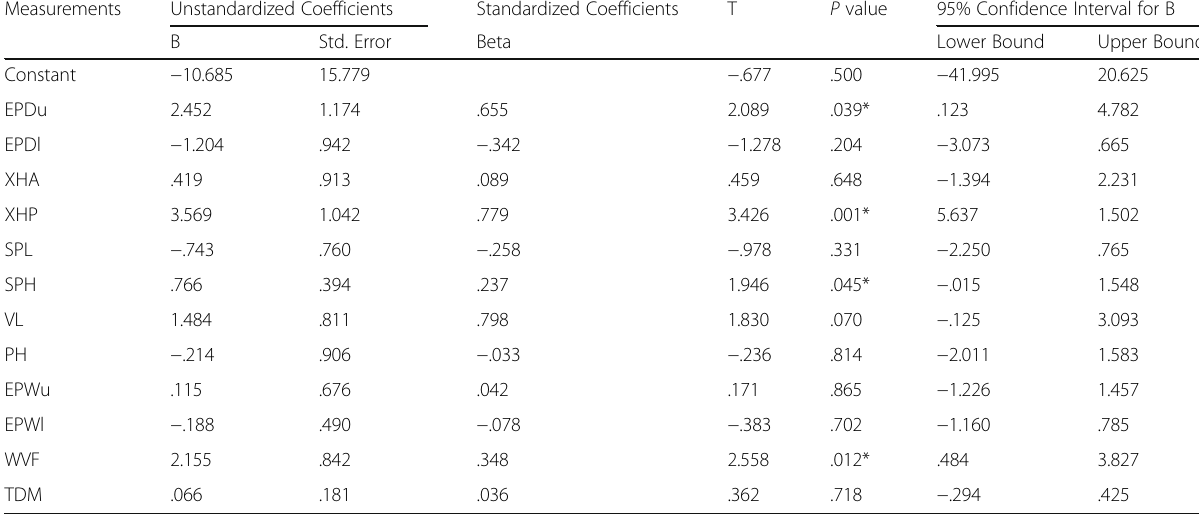
Table 4 Linear regression coefficients for age estimation from L1